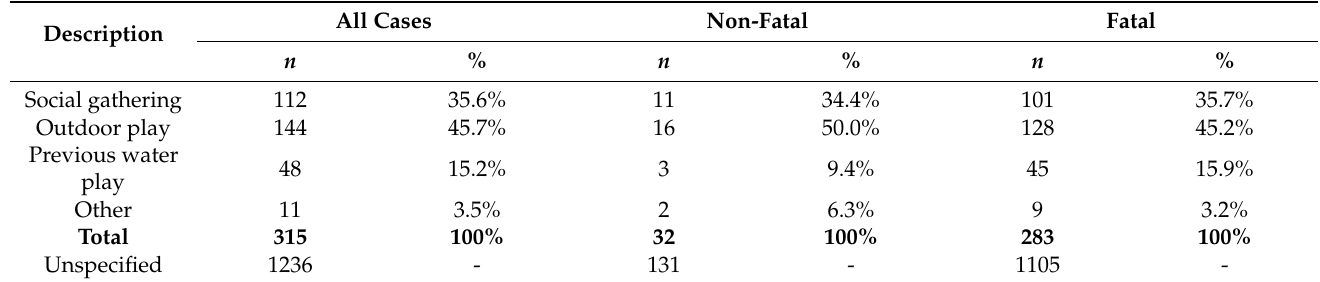
Table 5. Precipitating